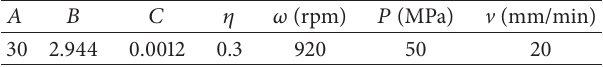
Table 1: Calculated parameters for the proposed model.